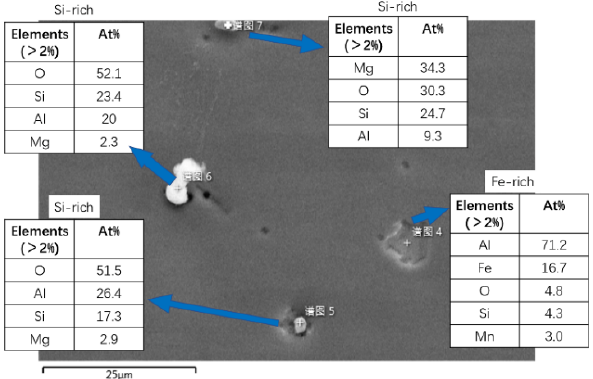
Figure 9. EDS (energy dispersive spectrometer) characteristics for di ff erent second phase particles in base metal.